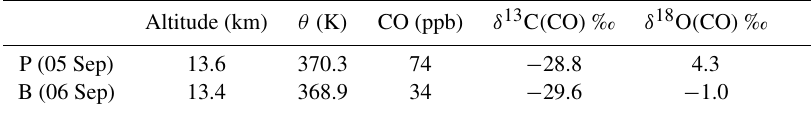
Table 4. LISA observations of CO, mole fractions and the carbon and oxygen isotopic composition of CO, of the plume, P, and background, B. Here δ 13 C ( CO ) is reported in per mille (‰) vs. VPDB and δ 18 O ( CO ) in per mille (‰) vs. VSMOW. Altitude